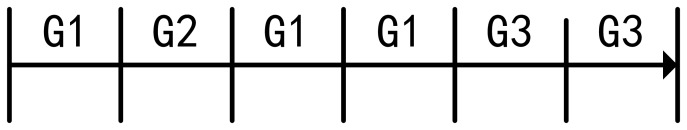
An example of one1dimensional RDD operator.There are 3 groups in this one-dimensional RDD example: G1, G2 and G3. And every dust belongs to these 3 groups randomly. In this example, 1st, 3rd and 4th dusts belong to G1, 2nd dust belongs to G2, and 5th and 6th dusts belong to G3.